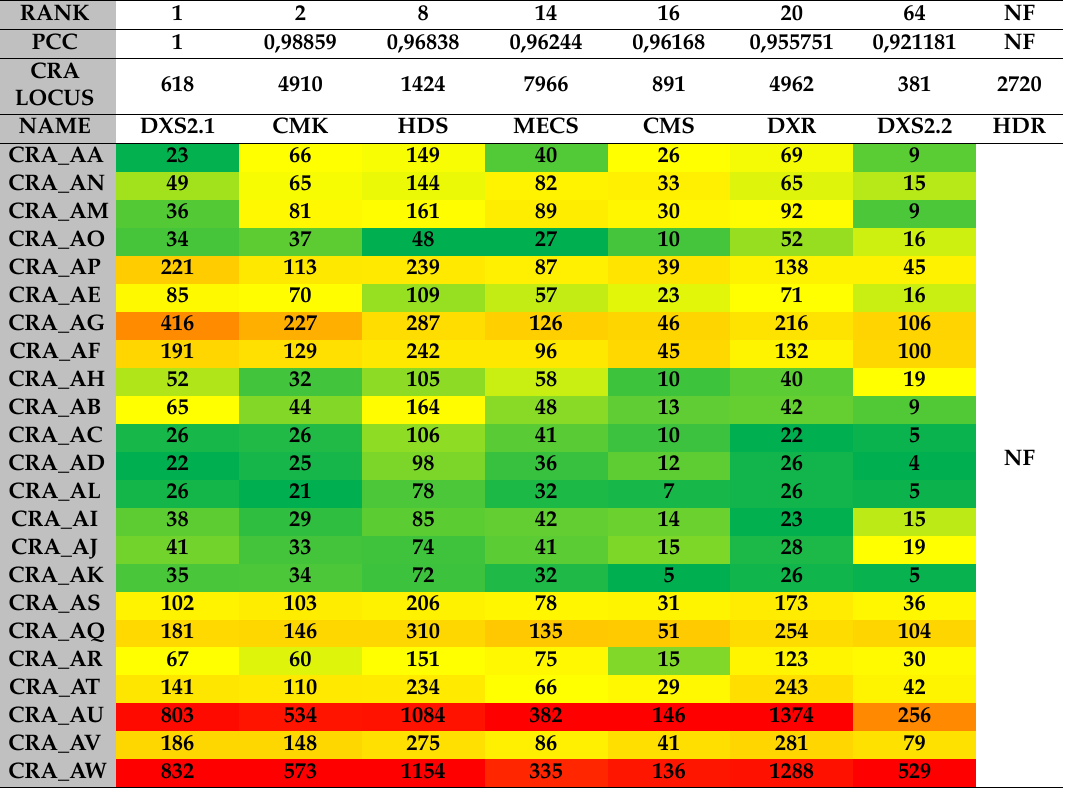
Table 2. MEP pathway gene RNA seq coexpression pattern. A DXS2.1 coexpression network was drawn using Medicinal Plant Genomics Ressource MPGR RNA seq data [44] showing the clustering of the MEP pathway genes. The codes for the 23 samples and the transcript accession numbers (i.e., cra locus numbers) are from MPGR. See methods for